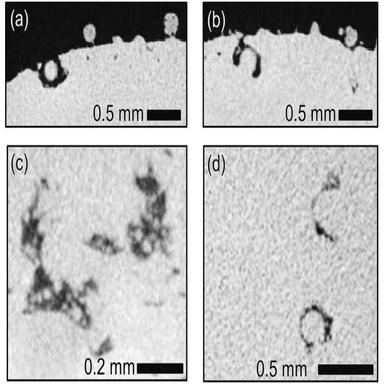
Examples of CT cross-sections of parts showing spatter particles generating deep recesses (a) and sub-surface open porosities (b). Examples of CT cross-sections of parts with internal LOF porosities characterized by entrapped powder particles (c) and spatter particles (d).